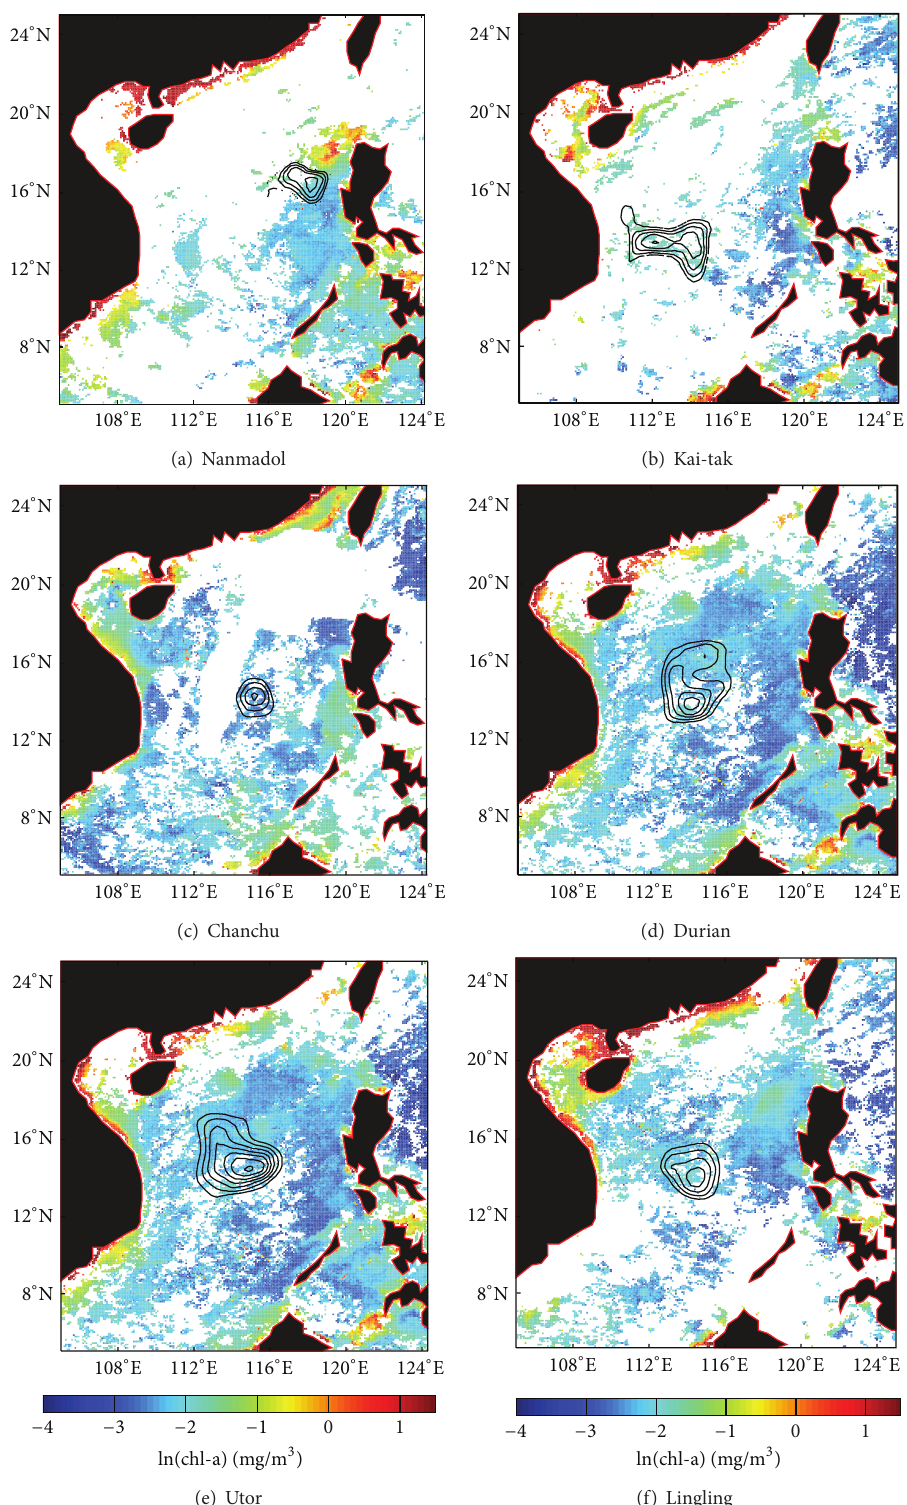
Figure 8: The chl-a concentration in preexisting CCEs before typhoons. Colorbar is the natural logarithm value of chl-a